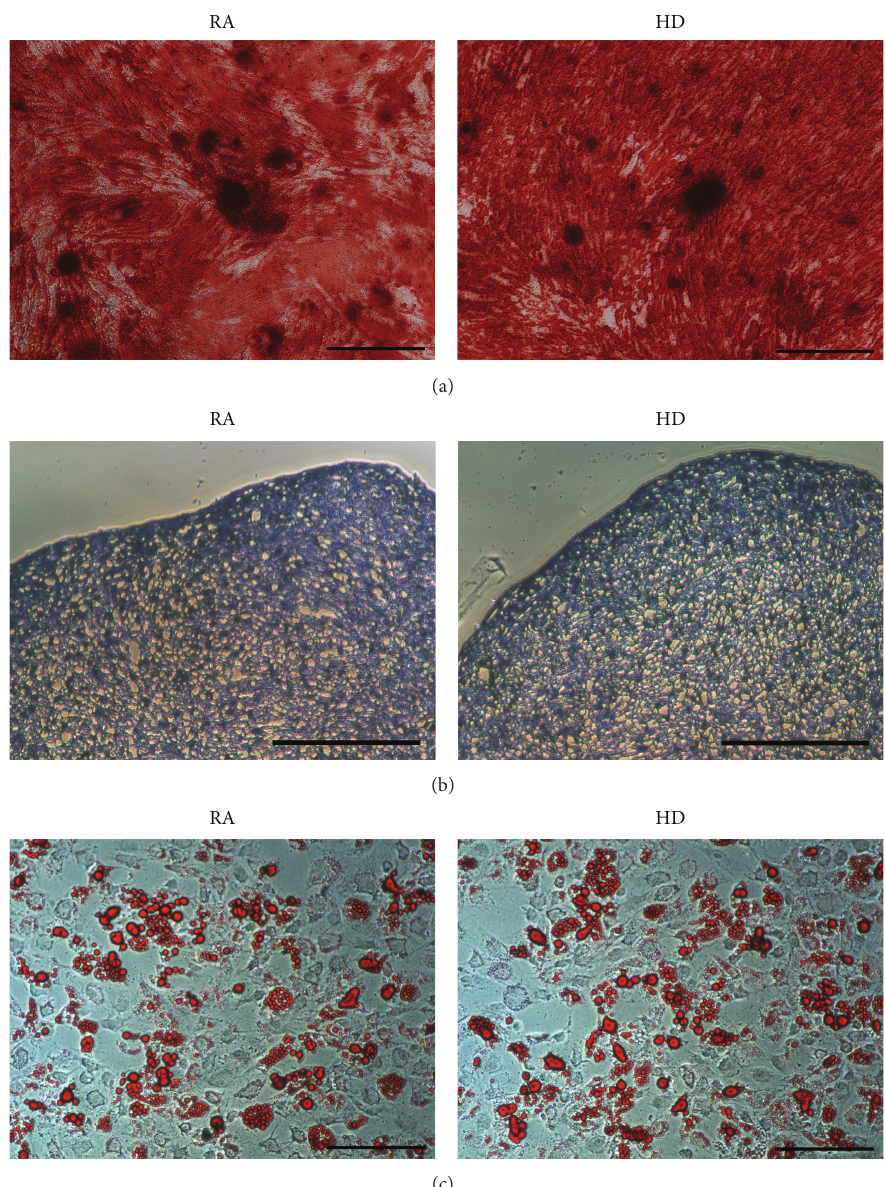
Figure 2: Triple SMSC differentiations. Osteogenic, chondrogenic, and adipogenic differentiation of SMSCs from RA patients and HDs were observed using an inverted phase-contrast microscope. (a) Osteogenic differentiation was indicated by mineralization nodes stained with alizarin red (scale bar: 200 𝜇 m). (b) Chondrogenic differentiation was identified by glycosaminoglycans stained with toluidine blue (scale bar: 200 𝜇 m). (c) Adipogenic differentiation was identified by lipid vacuoles stained with oil red O (scale bar: 200 𝜇